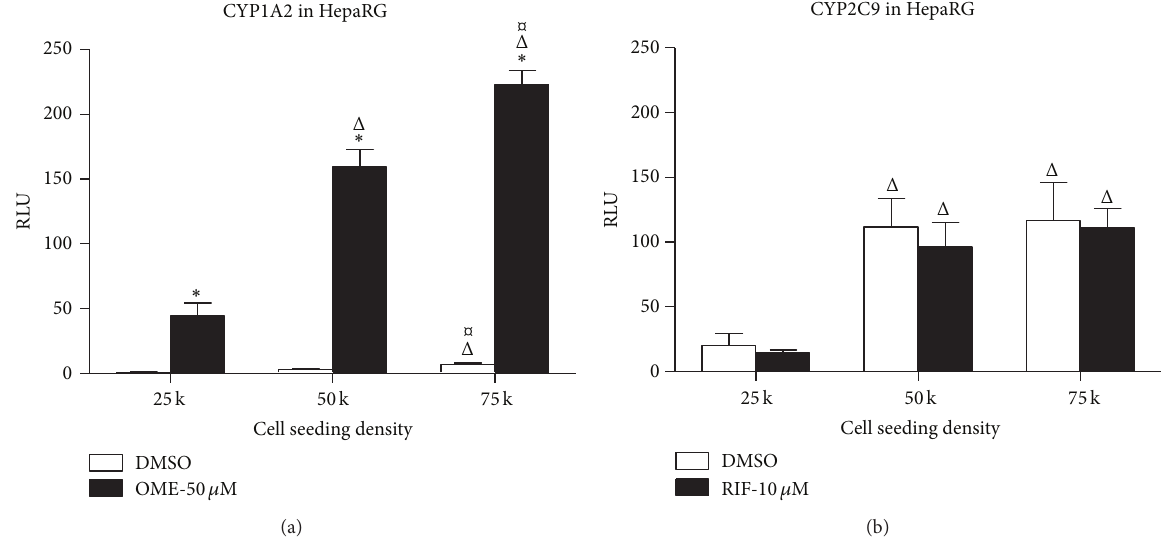
Figure 4: Induction of CYP1A2 but not CYP2C9 in cryopreserved HepaRG cells. (a) CYP1A2 induction in HepaRG cells plated in 96-well plates at seeding densities of 25,000, 50,000, and 75,000 cells per well and treated with DMSO (0.1%) or omeprazole (OME, 50 𝜇 M) for 72 hrs starting at Day 3 in culture. Data represent mean ± SEM for 3 independent experiments. ∗ represents 𝑃 < 0.05 versus DMSO-treated cells; Δ represents 𝑃 < 0.05 versus cells seeded at 25,000 cells per well; ¤ represents 𝑃 < 0.05 versus cells seeded at 50,000 cells per well. (b) Treatment with DMSO (0.1%) or rifampicin (RIF, 10 𝜇 M) for 72 hrs starting at Day 3 in culture in HepaRG cells plated in 96-well plates at seeding densities of 25,000, 50,000, and 75,000 cells per well. Data represent mean ± SEM for 3 independent experiments. Δ represents 𝑃 < 0.05 versus cells seeded at 25,000 cells per well.